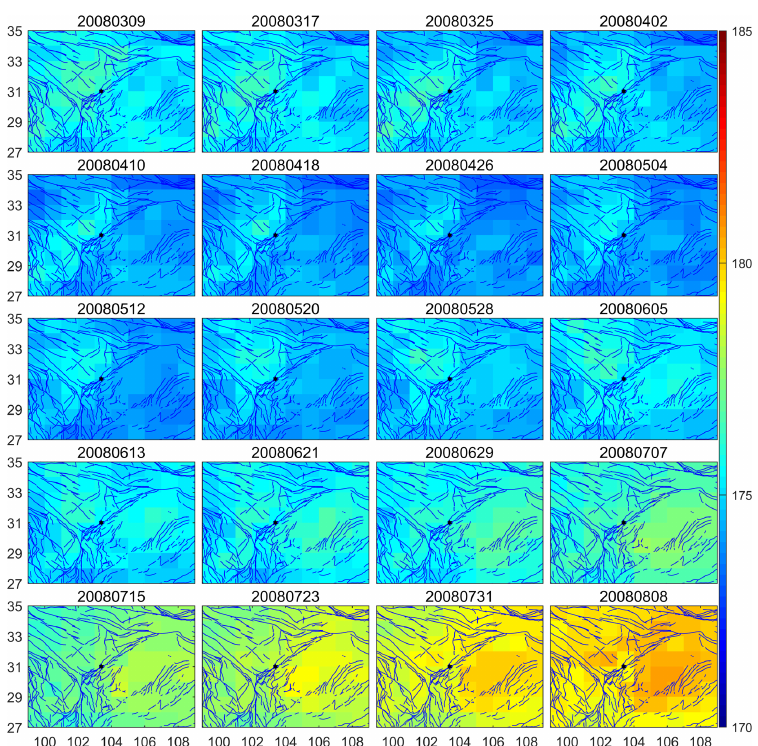
Figure 2. The 5-year (2003 to 2007) average distribution of 8d nighttime CH 4 volume mixing ratios at